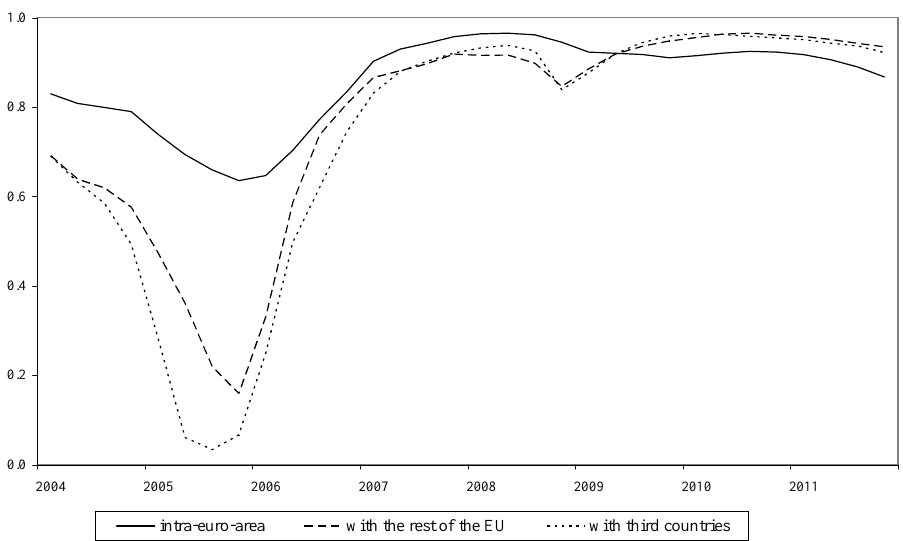
Figure 1. Mean cyclical correlations with the euro area for a 4-year rolling